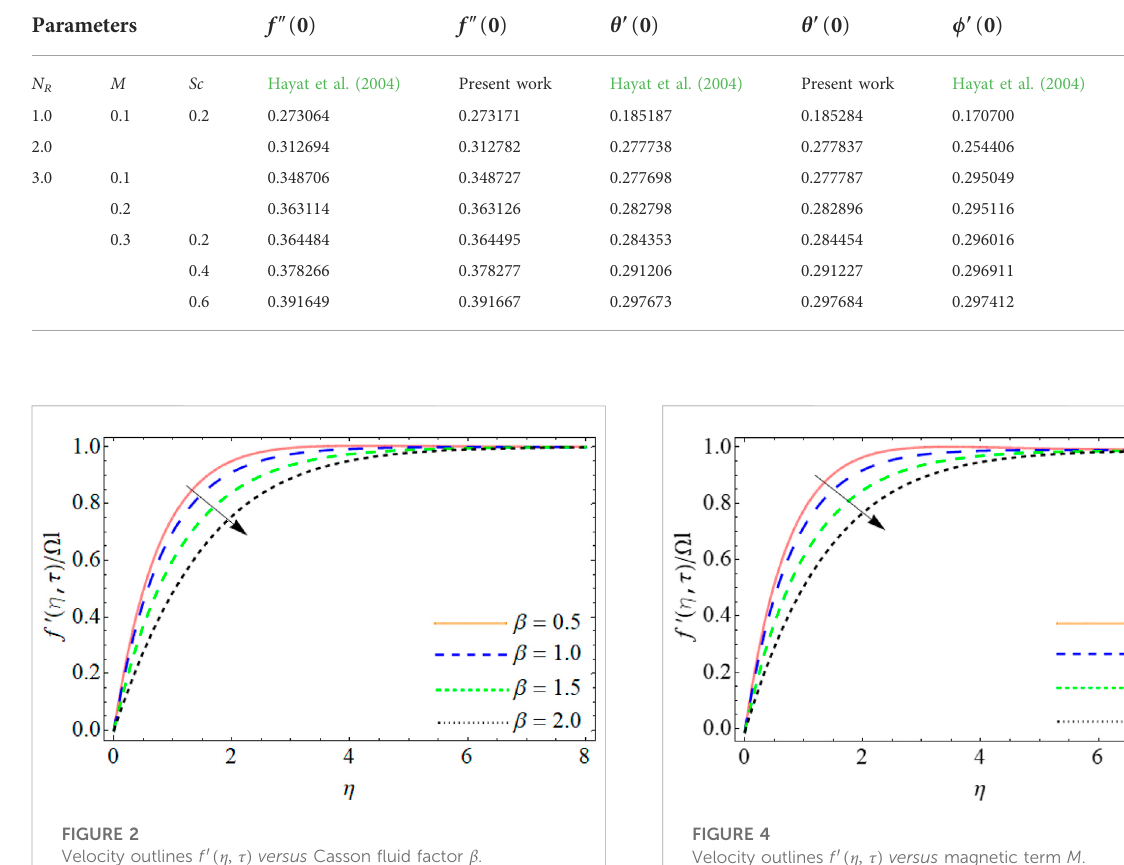
FIGURE 4 Velocity outlines f ′ ( η , τ ) versus magnetic term M .